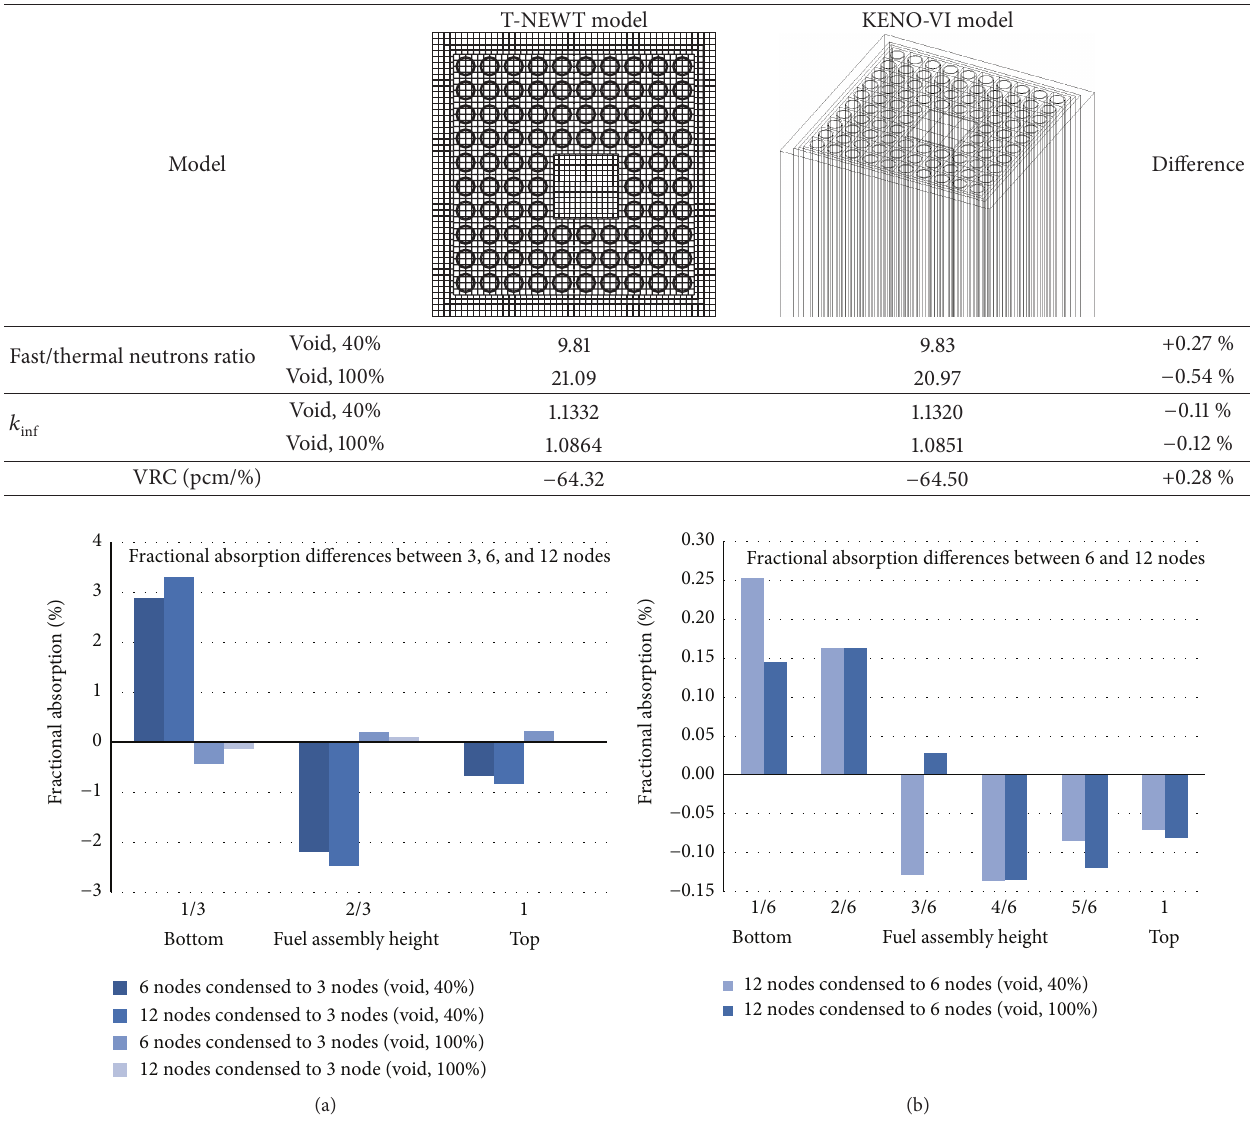
Figure 4: Distributions of fractional neutron absorption in cases of normal conditions and